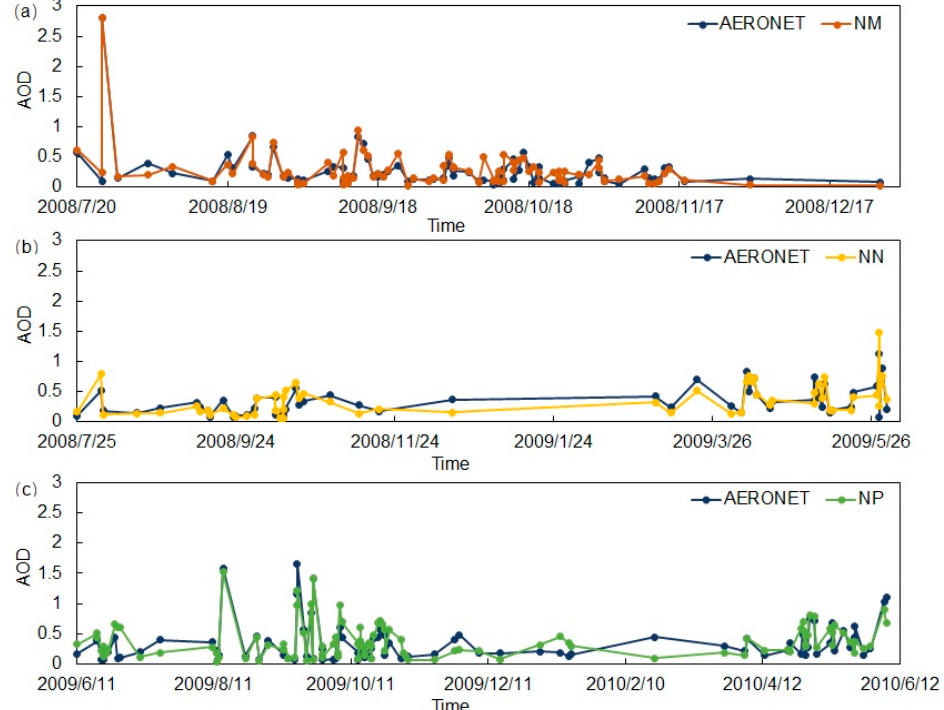
Figure 17. Time series of AVHRR AOD retrievals at 0.55 μ m versus AERONET AOD measurements at 0.55 μ m. The three AVHRR onboard satellites were involved: ( a ) NM; ( b ) NN; ( c ) NP. The conventional estimate of AOD at 0.55 μ m using 0.63 μ m channel was also retrieved. The conventional estimate of AOD used the same clear day results as the 𝑘′ ratio. Validation against the AEROENT measurement in Figure 18 shows that the linear regression equation is 𝑦 = 0.17 + 0.57 𝑥 with an 𝑅 of 0.78 and an RMSE error of 0.22, which is inferior to the AOD retrieval using the 𝑘′ ratio.